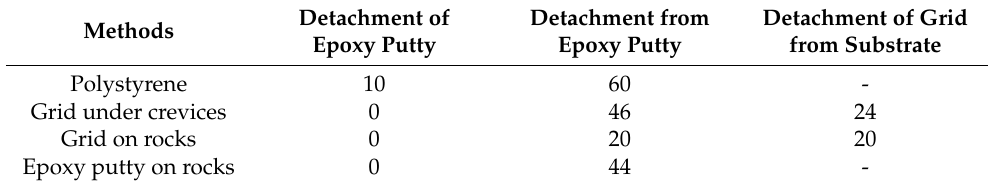
Table 1. The percentage of transplant loss due to the different method failure reasons for each method.